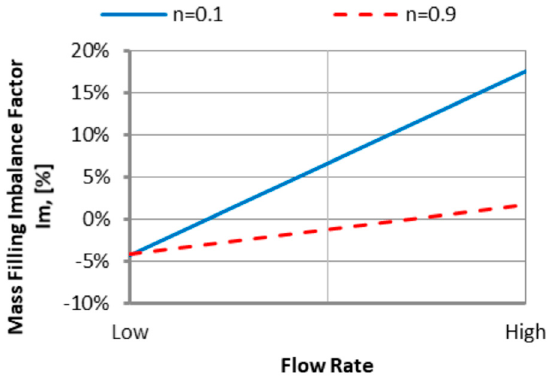
Figure 15. An effect of the power law index n on the mass filling imbalance factor I m at various injection rates (Low = 5 cm 3 /s, High = 500 cm 3 /s).